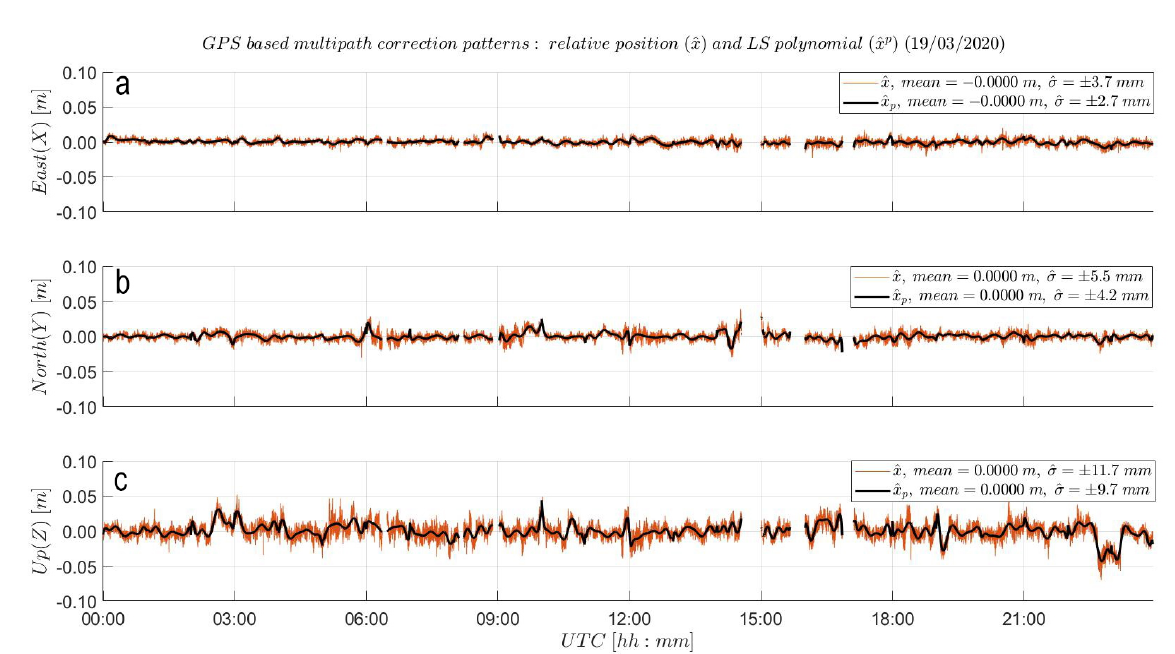
Figure A2. Definition of LS based MP correction ( ˆ x p ): The process was run on one-hour-long sequences of the baseline time series ( ˆ x ) of day 079 to model the MP behaviour at reference and rover station site. The resulting one-hour-long LS polynomial sequences were merged together to form high-rate (5 Hz) GPS-only MP corrections (black) in ( a ) East, ( b ) North and ( c ) Up. This is further used in the definition of the noise-level time series (ˆ e ) from Figure 7. Small gaps in the data correspond to filtered out float baseline solutions. Note the sidereal period of the time scale on the horizontal axis. The